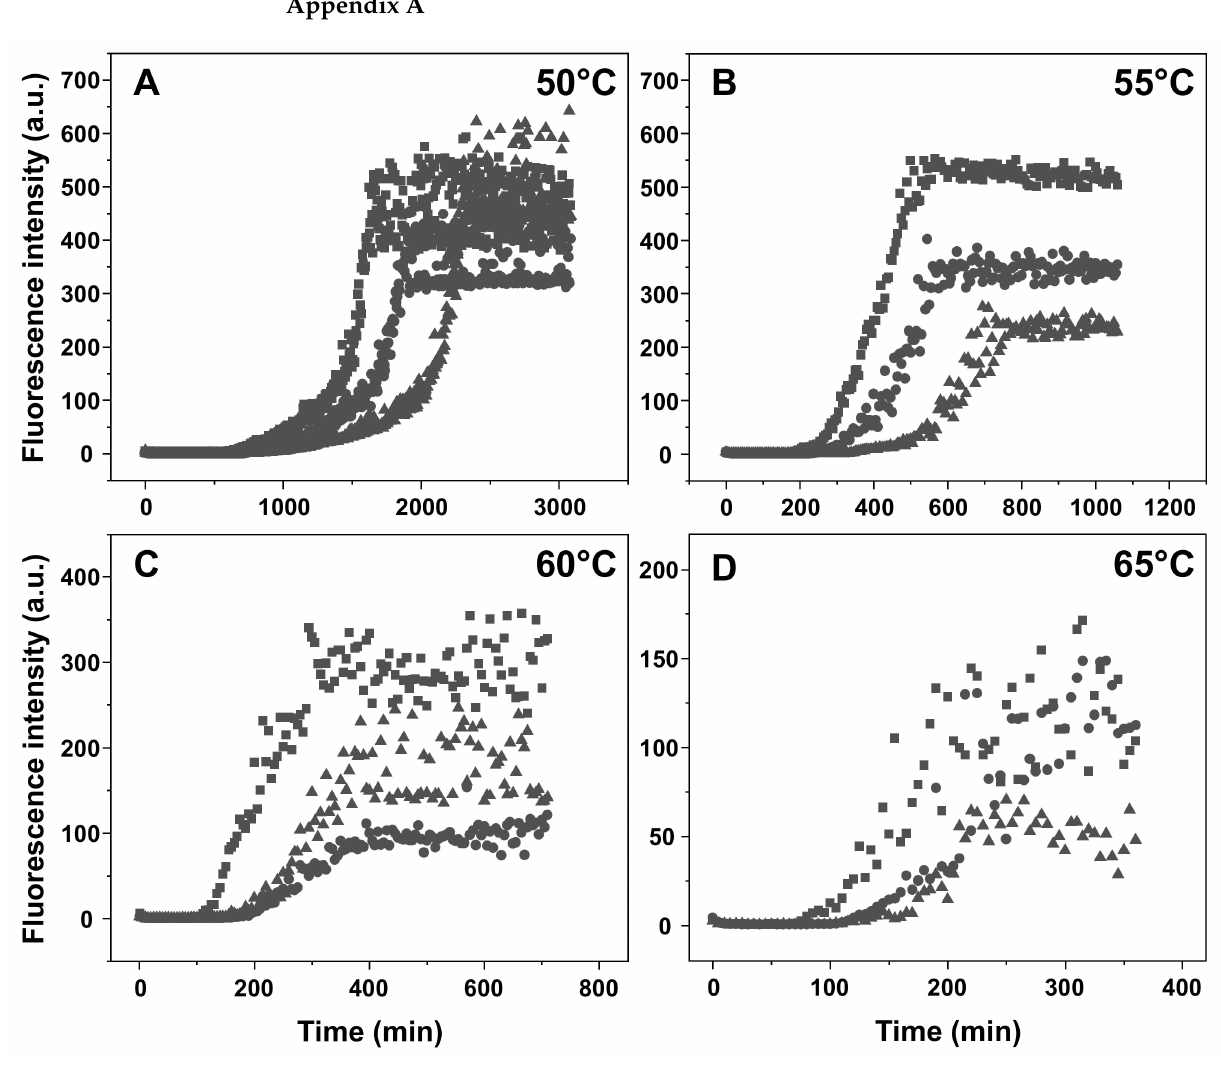
Figure A1. Examples of lysozyme aggregation kinetic curves at 50 ◦ C ( A ), 55 ◦ C ( B ), 60 ◦ C ( C ) and 65 ◦ C ( D ). Kinetic curves are from three repeats (different symbols represent separate